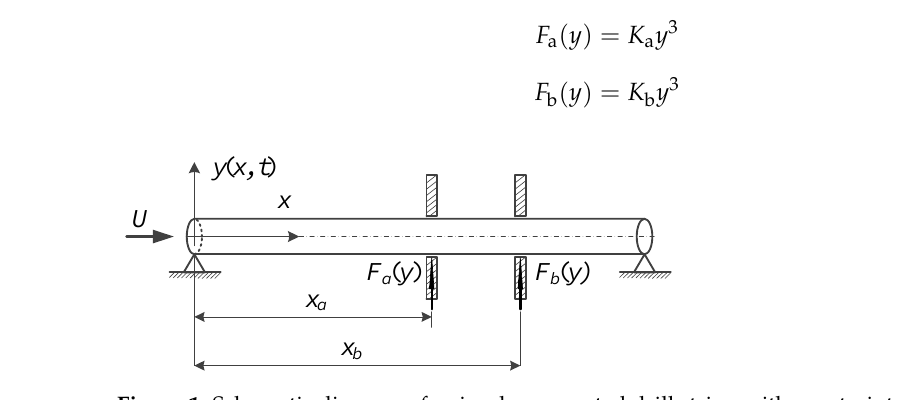
Figure 1. Schematic diagram of a simply supported drill string with constraints.